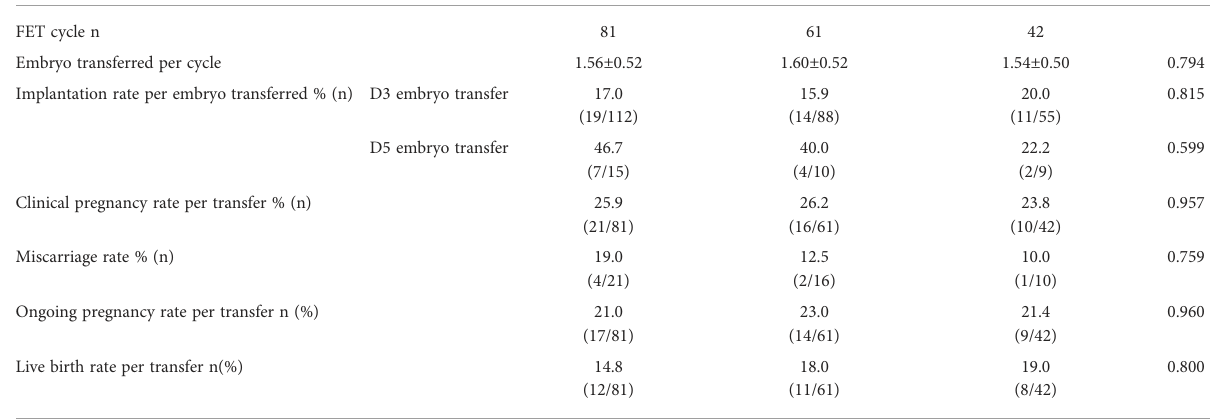
TABLE 4 Clinical outcomes of frozen-thawed embryo transfers originating from different gonadotropin initial phase groups.